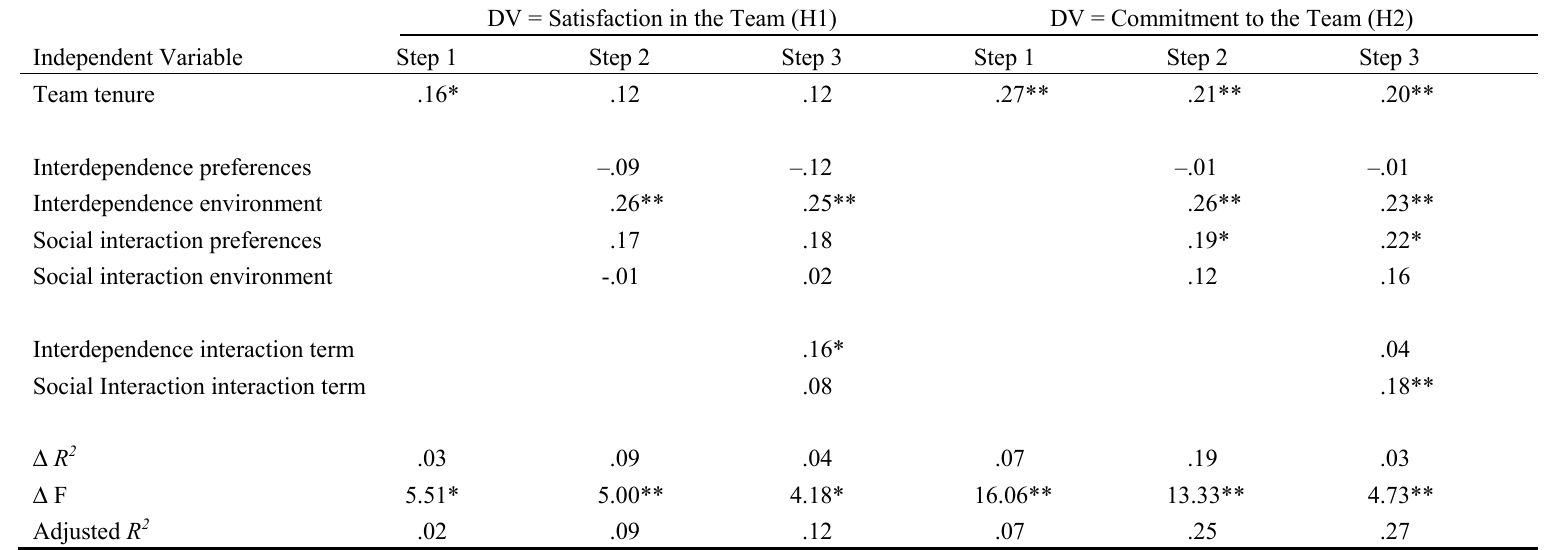
Table 2. Results of hierarchical moderated regression analyses: satisfaction in the team and commitment to the team. DV = Satisfaction in the Team (H1) DV = Commitment to the Team (H2) Independent Variable Step 1 Step 2 Step 3 Step 1 Step 2 Step